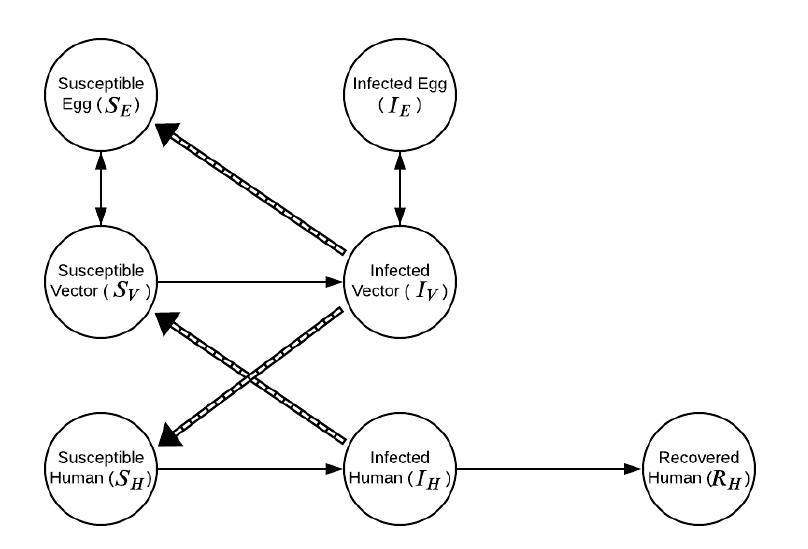
Figure 1. SI-SI-SIR model compartments. S E , I E , S V and I V , S H , I H and R H represent the non- infected and infected eggs of the vector population; the susceptible and infectious compartments of the adult mosquito population; and the susceptible, infectious and recovered portions of the human population, respectively. Solid arrows indicates transmission